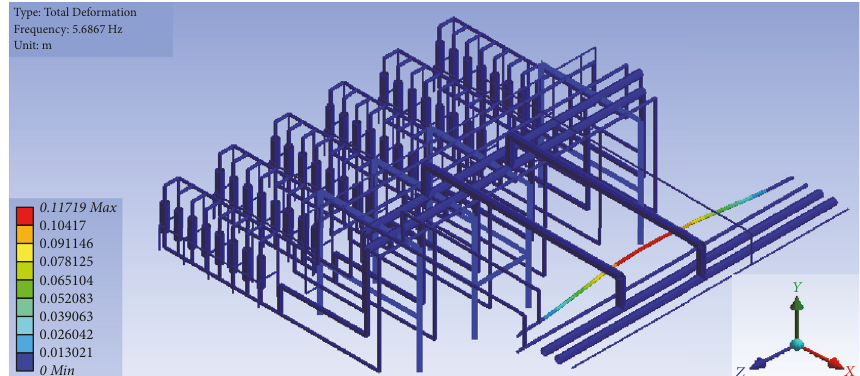
Figure 8: Vibration mode of the 3rd modal